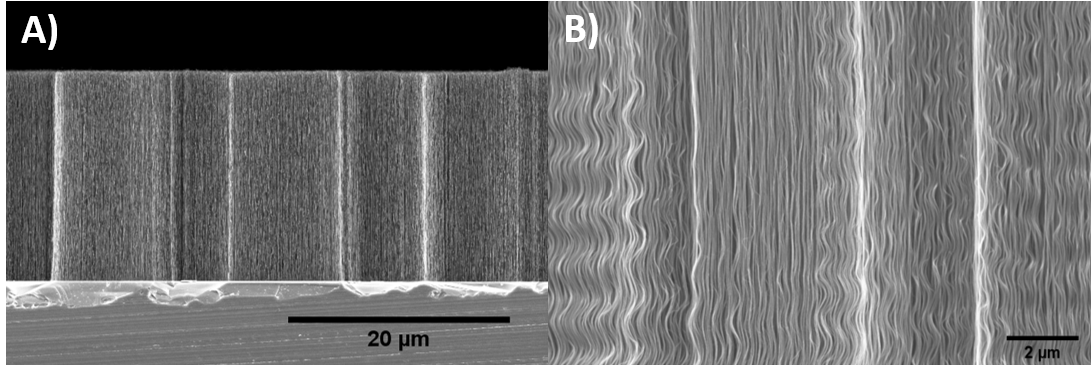
Figure 2. ( A ) Side view SEM image of a CNT array grown on a silicon substrate using the CVD